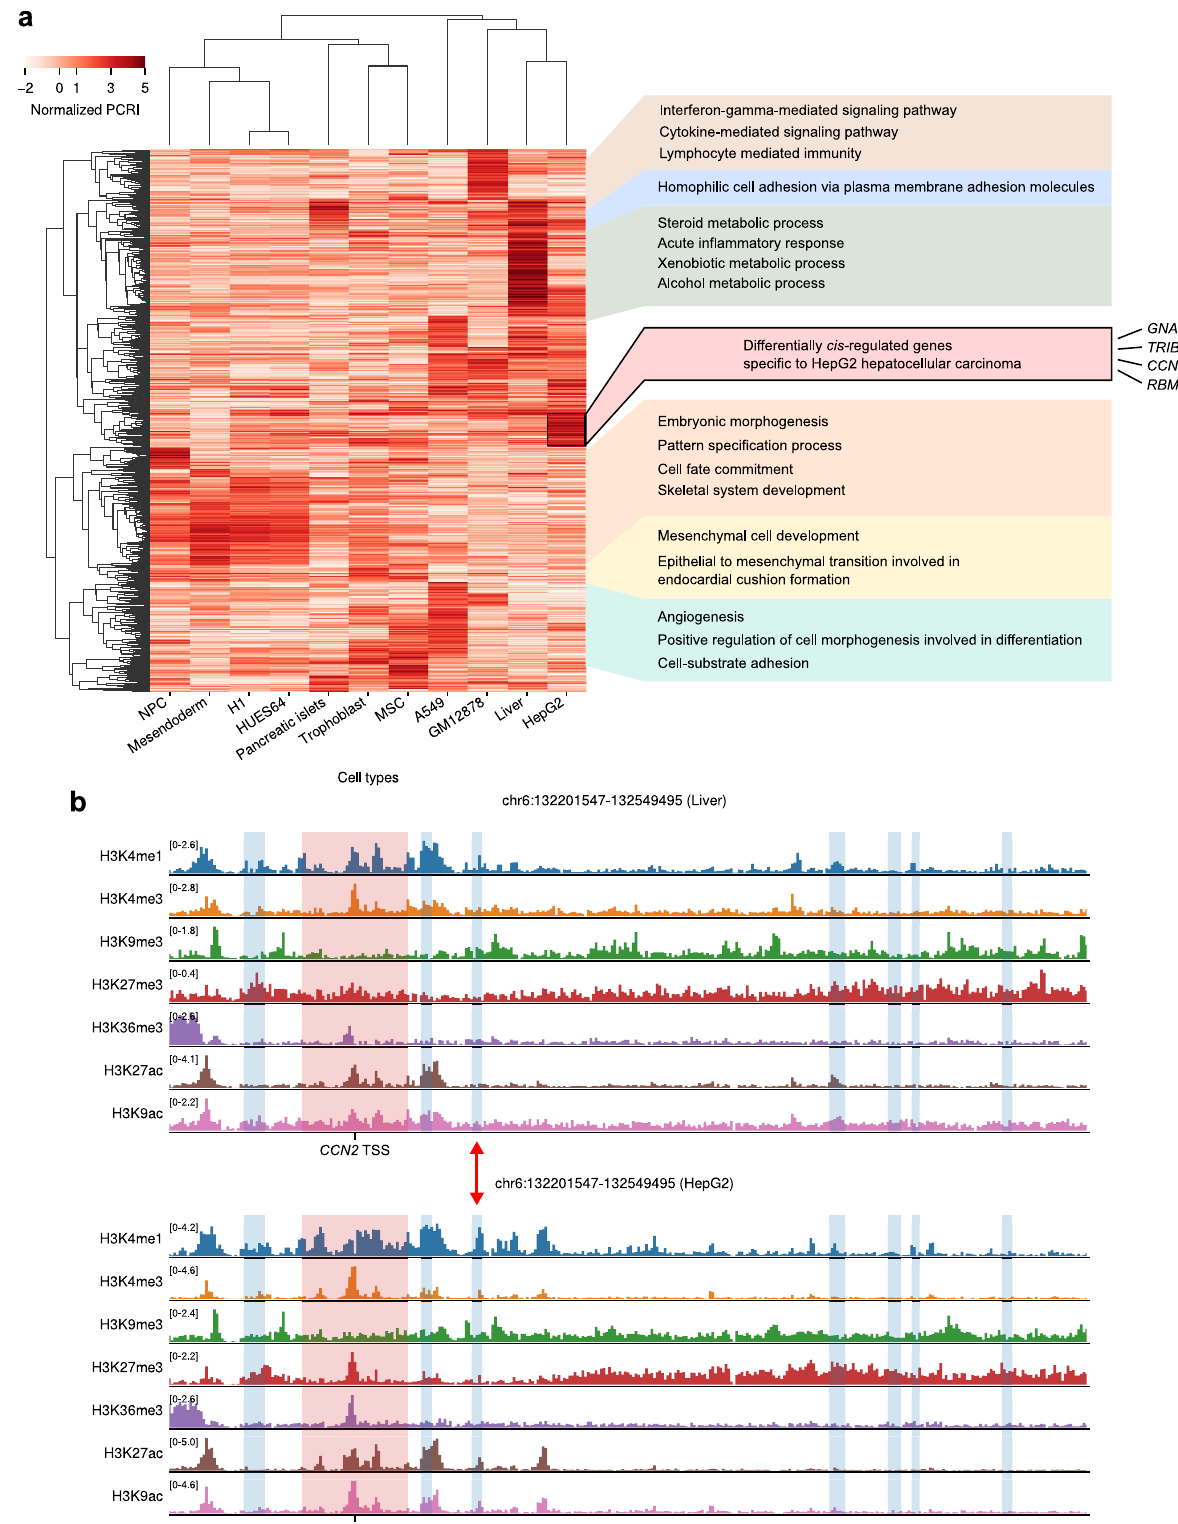
Fig. 6 | Differential cis -regulome analysis using PCRI values. a Hierarchical clustering of top 1000 genes having the highest normalized PCRI variances across celltypes.RepresentativeGOtermsenrichedforthecorrespondingsetofgenesare shown on the right. b Histone modi fi cation landscape around the transcription